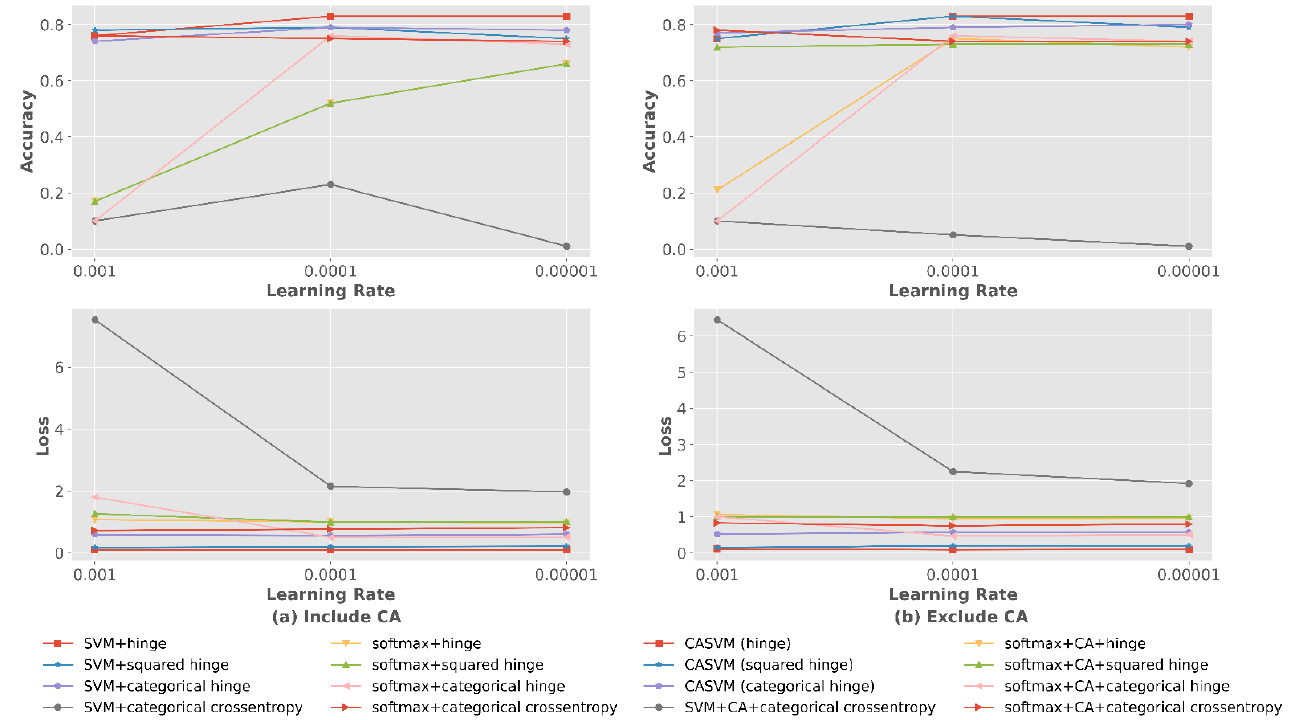
Figure 3. Impact of attention mechanism and different loss functions on classification accuracy.